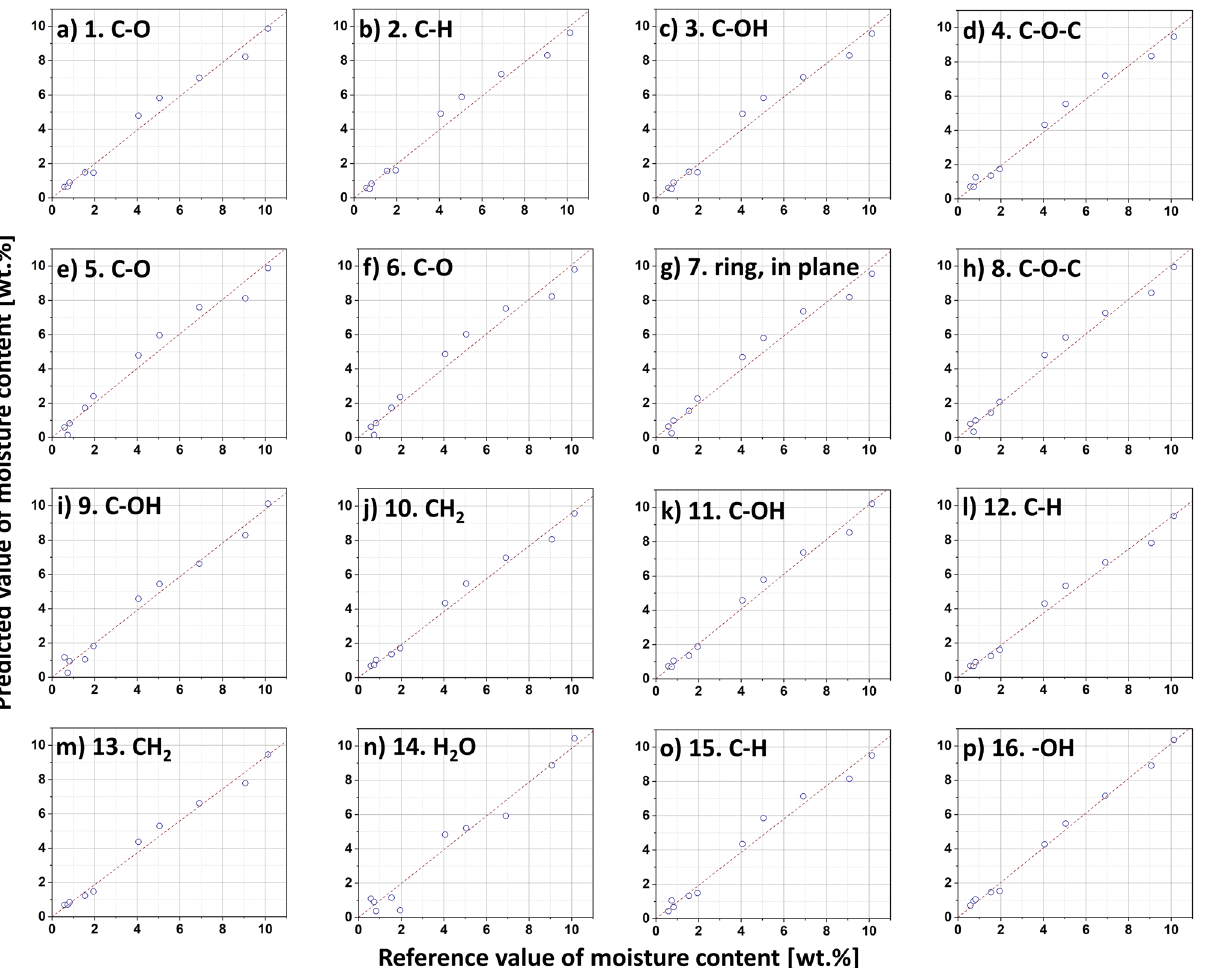
Figure 3. External validation results of water content prediction for cellulose fibres. The predictions of the moisture content obtained with the ATR FT-IR approach were compared to the Karl-Fischer titration